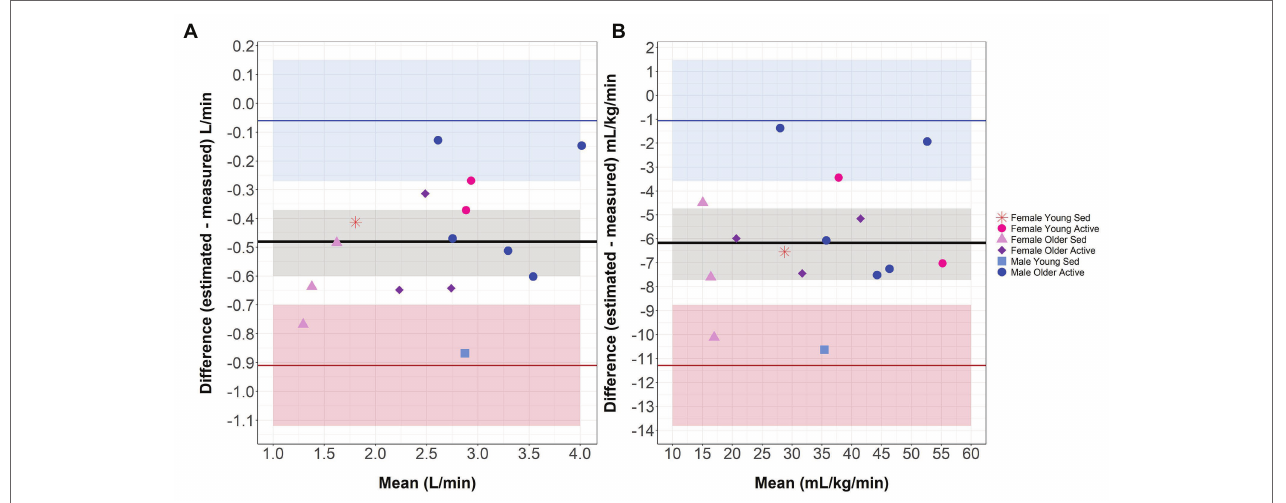
FIGURE 2 | Bland-Altman Plot. Bland-Altman Analyses Plot between differences in estimated and measured VO 2 max compared to mean VO 2 max in L min −1 (A) and ml kg −1 min −1 (B) . Horizontal lines represent mean bias (black line), upper Limit of Agreement (LoA; blue line), lower LoA (red line). Shaded areas represent 95% CIs around mean bias (gray), upper COA (blue), and lower LoA (red). Individuals are coded by gender, age (Young = 25–28 years old; Older = 56–73 years old), and current physical activity level (Sedentary = 198–900 MET-minutes/week; Active = 4,236–25,992 MET-minutes/week). VO 2 max, maximal oxygen consumption; Sed,